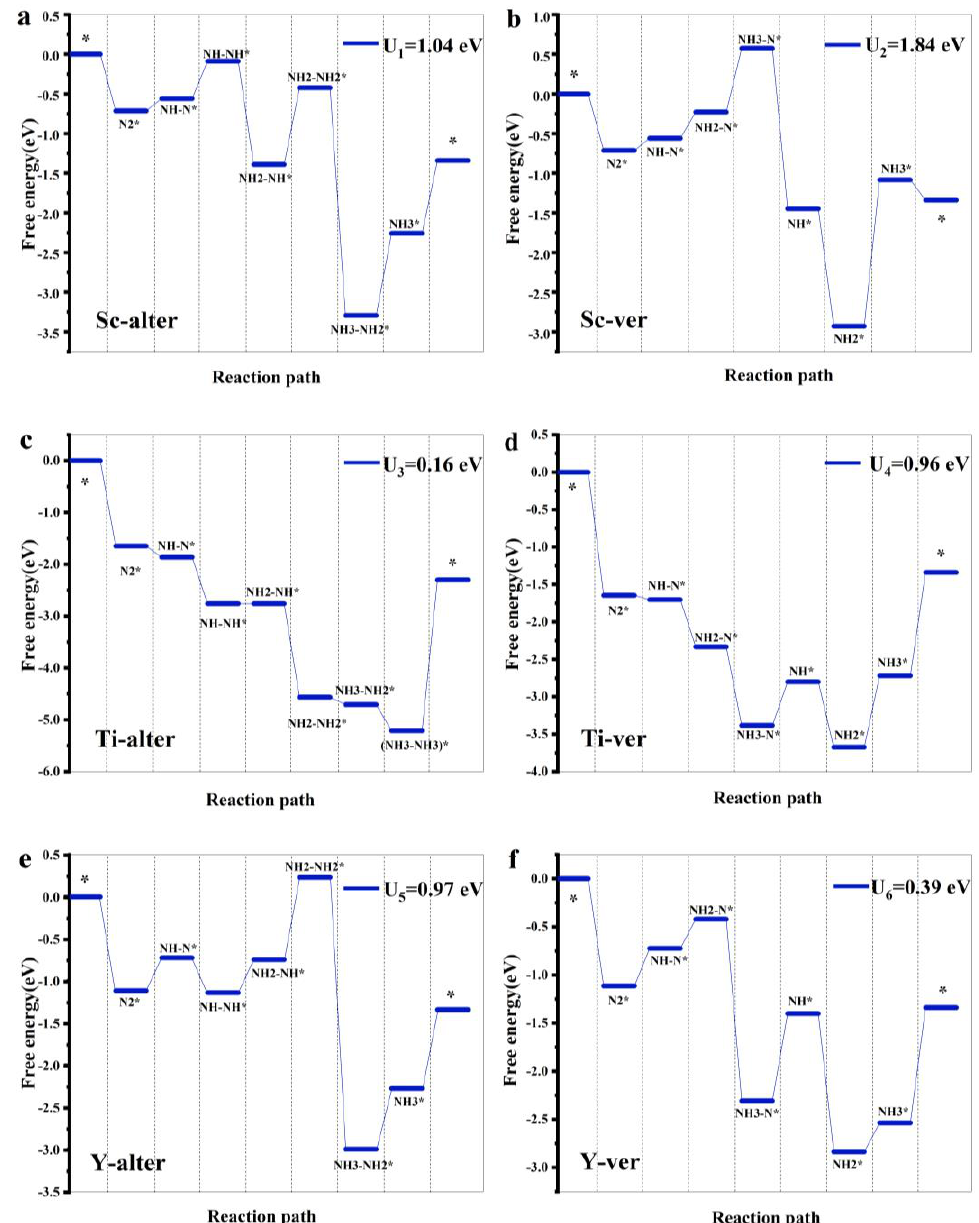
Figure 3. ( a ) Path diagram of the free energy reaction path of NRR alternating mechanism on Sc-Mn-N 6 ; ( b ) Path diagram of the free energy reaction of NRR vertical mechanism on Sc-Mn-N 6 ; ( c ) Path diagram of the free energy reaction path of NRR alternating mechanism on Ti-Mn-N 6 ; ( d ) Free energy reaction path diagram of the vertical mechanism of NRR on Ti-Mn-N 6 ; ( e ) Free energy reaction path diagram of NRR alternating mechanism on Y-Mn-N 6 ; ( f ) Path map of the free energy reaction path of the NRR vertical mechanism on Y-Mn-N 6 . * in the Figure represent adsorbed structure.